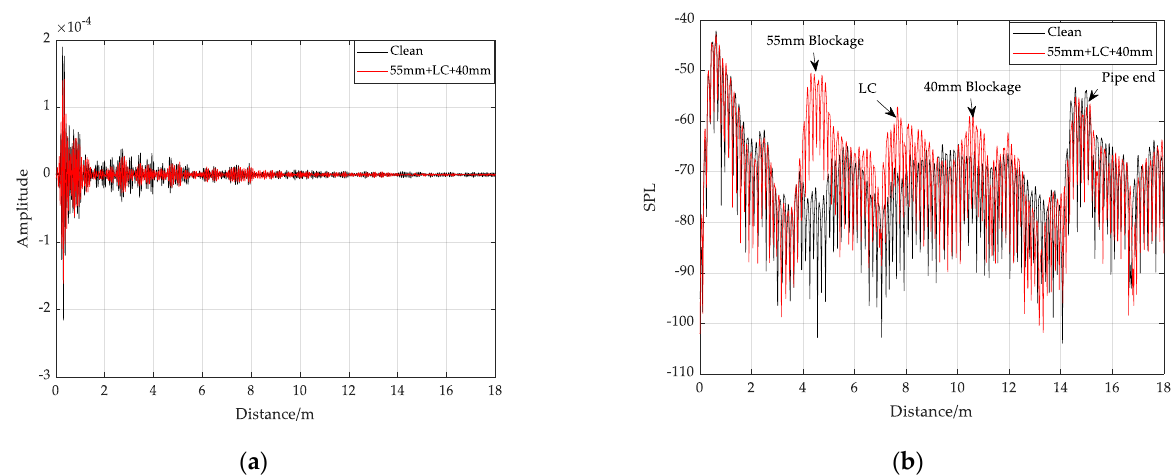
Figure 7. Conversion diagrams of sound pressure level: ( a ) sound pressure signal; ( b ) sound pressure level conversion.